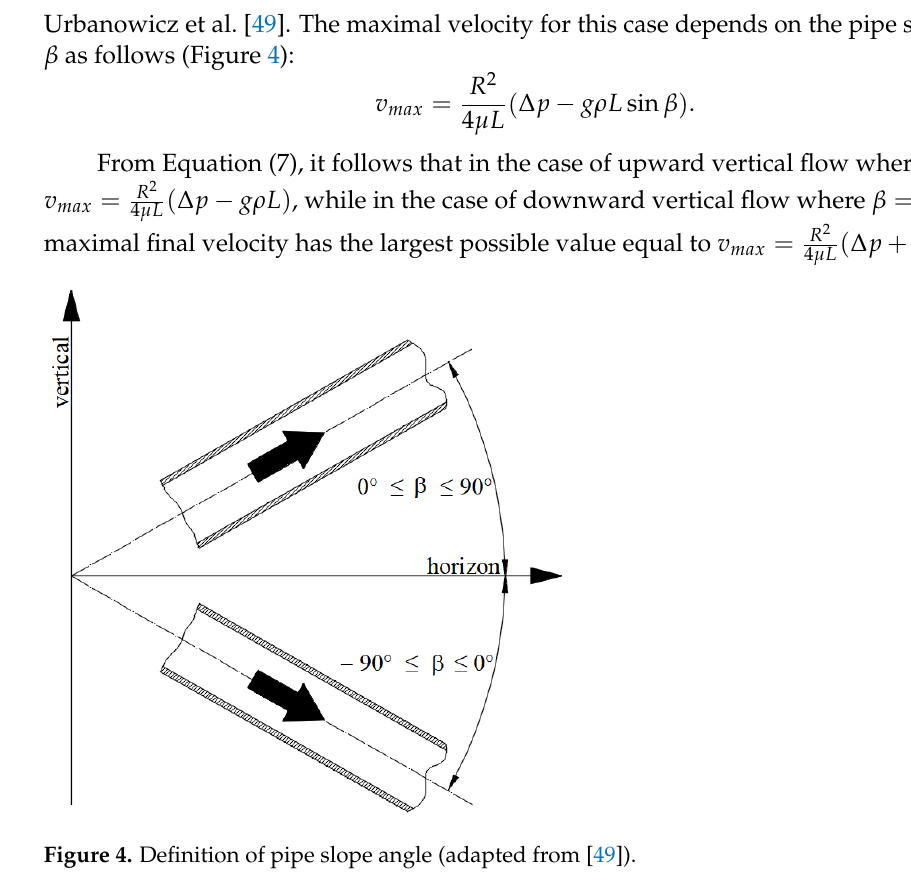
Figure 3. Development of velocity profile in RGS-accelerated flow driven by a step change of pres- sure gradient.